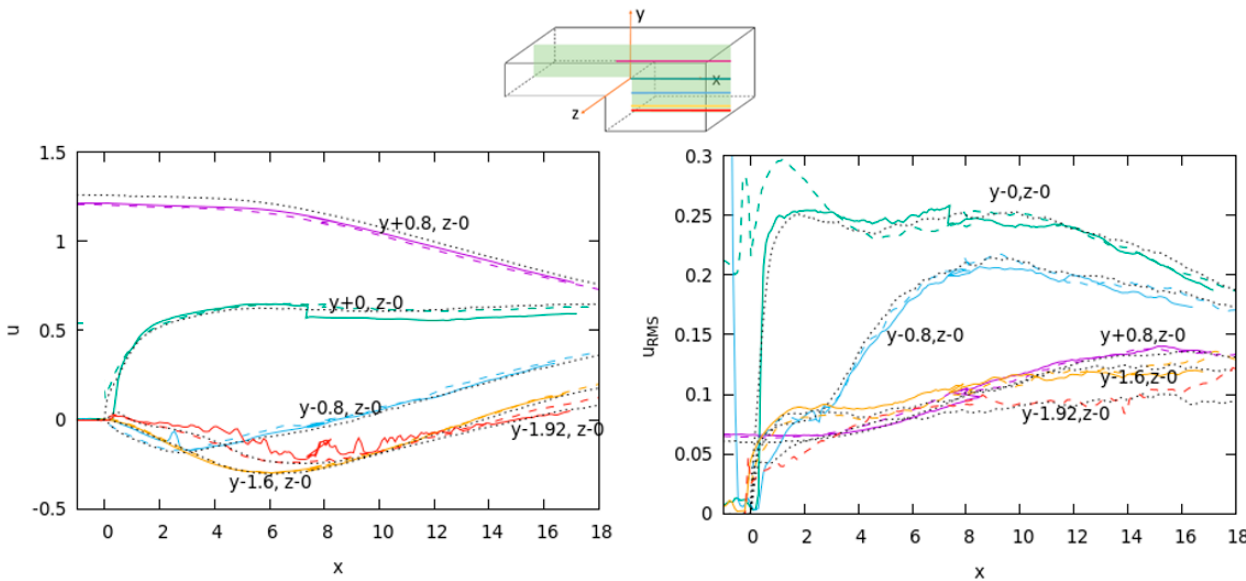
Figure 11. Mean streamwise velocity u and velocity fluctuations u RMS at cross-sections of the measurement planes. Dashed lines: profiles of the case ‘z − 0’ in line segments at y = − 1.92, − 1.6, − 0.8, 0, 0.8. Solid lines: profiles from cases ‘y − 1.92’, ‘y − 1.6’, ‘y − 0.8’, ‘y − 0’, and ‘y + 0.8’ at z = 0. DNS—black dotted lines.